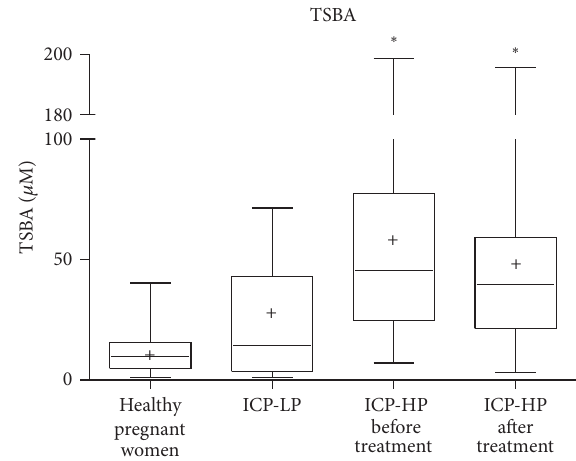
F 1: TSBA levels in the groups studied: healthy